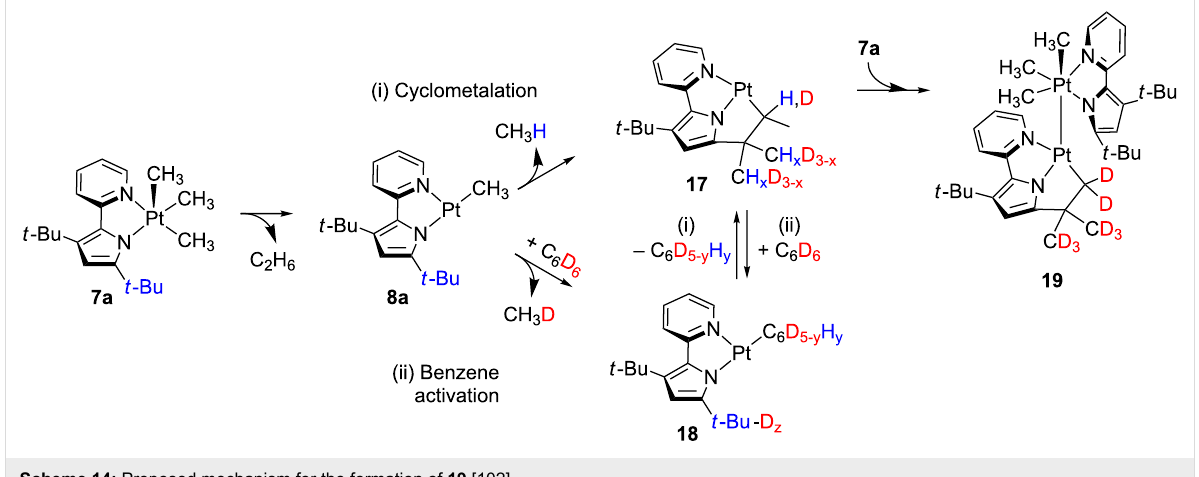
Scheme 14: Proposed mechanism for the formation of 19 [102].